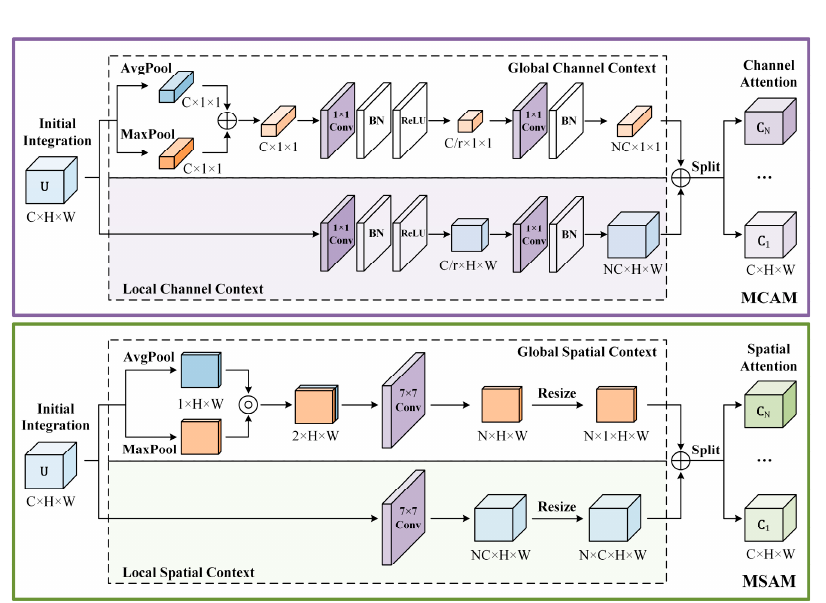
Figure 11. Diagram of the AWF. To generate the non-linear fusion weight a n , an element-wise soft- max is performed on the integrated attention descriptors A n , fused by multi-scale channel attention C n and multi-scale spatial attention S n .